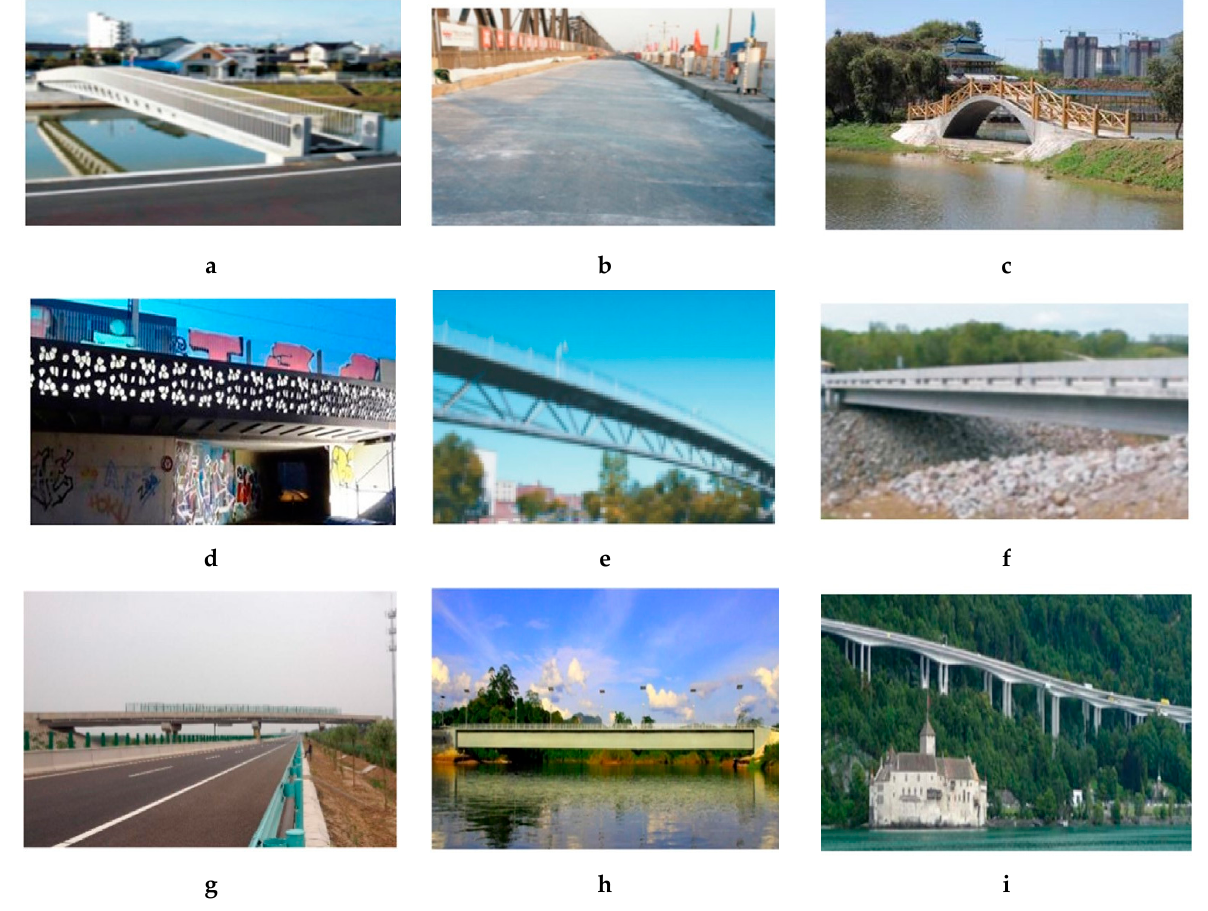
Figure 3. Typical apps of UHPC in BE: ( a ) Sakata ‐ Mirar foot BE; ( b ) Zhaoqing Mafang BE; ( c ) ultra ‐ high ‐ performance, fiber ‐ reinforced concrete arch BE in Fuzhou University campus viaducts; ( d ) Martinet foot BE; ( e ) Sherbrooke pedestrian BE; ( f ) Mars Hill BE; ( g ) Shijiazhuang to Cixian highway BE; ( h ) Batu 6 BE; ( i ) Chillon [53,91–94 ] . UHPCs can be utilized in BE decks, girders, arch rings, and other elements. Table 3 provides a brief overview of the utilization of UHPCs in BE components. In the sections below, the authors highlighted the most common benefits of UHPC in BEs that have been investigated in the literature. Table 3. Applications of UHPC in BE elements.